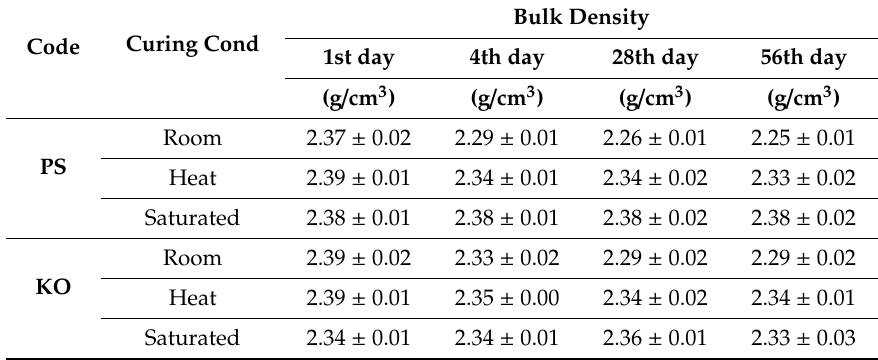
Figure 9. Experimental results of MIP measurements of room and heat-treated mortars: ( a ) cumulative pore volume and ( b ) relative pore size distribution. Table 6. Bulk density of IP mortars and corresponding standard